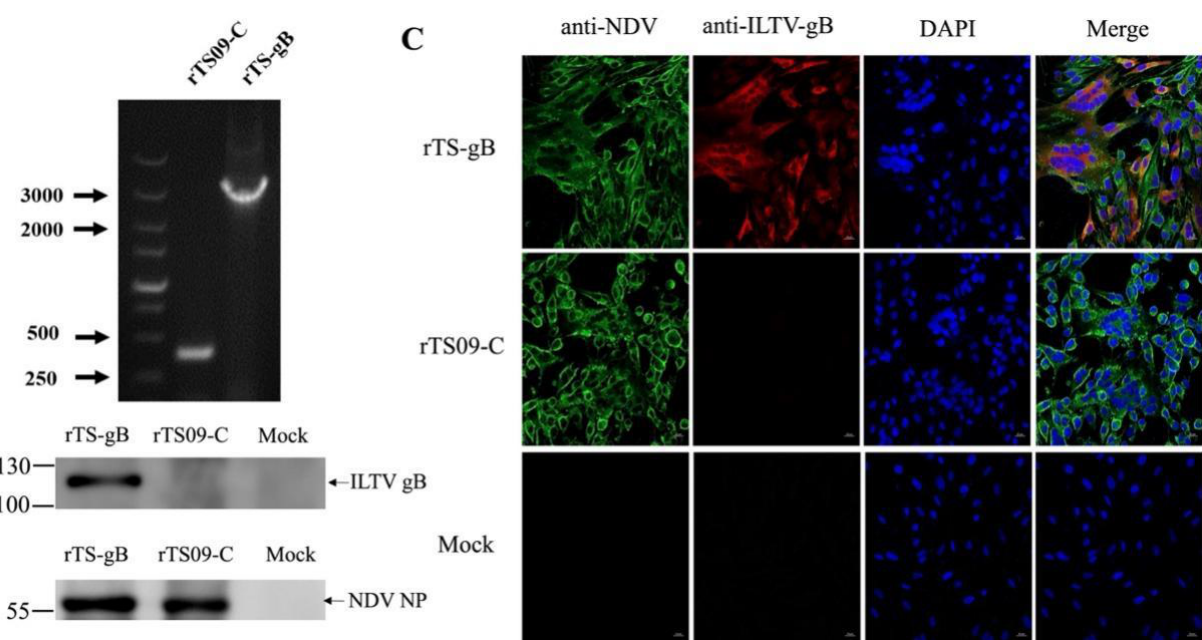
Figure 1. Schematic representation of the genome of the rNDV strain rTS-gB. The gB gene of ILTV